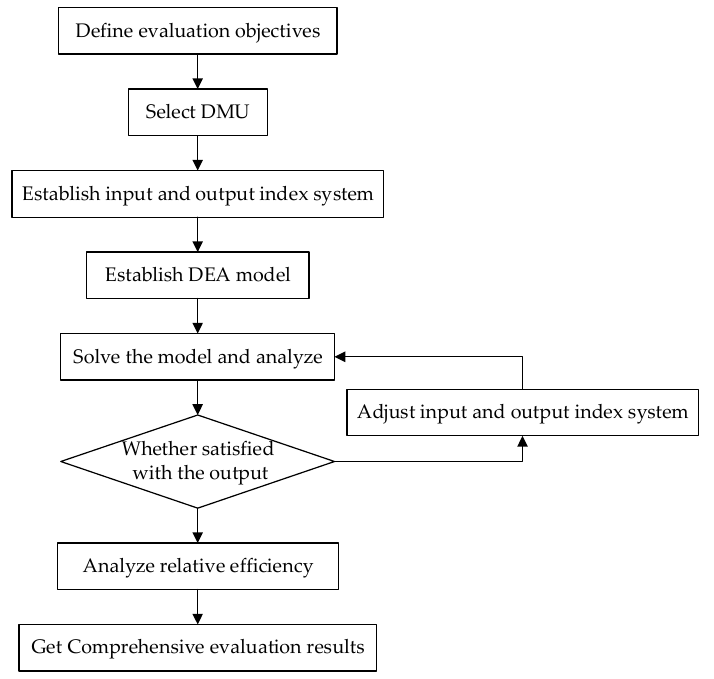
Figure 2. The flowchart of the